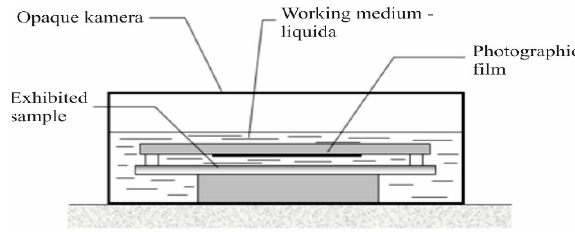
Figure 1. Scheme of the camera for chemographic exami– nation of samples During the exposure, the photo emulsion is processed by a stream of products of heterogeneous reactions emitted from the investigated surface with the formation of a latent image in the photo emulsion [8]. FN-64 sheet negative panchromatic photographic film